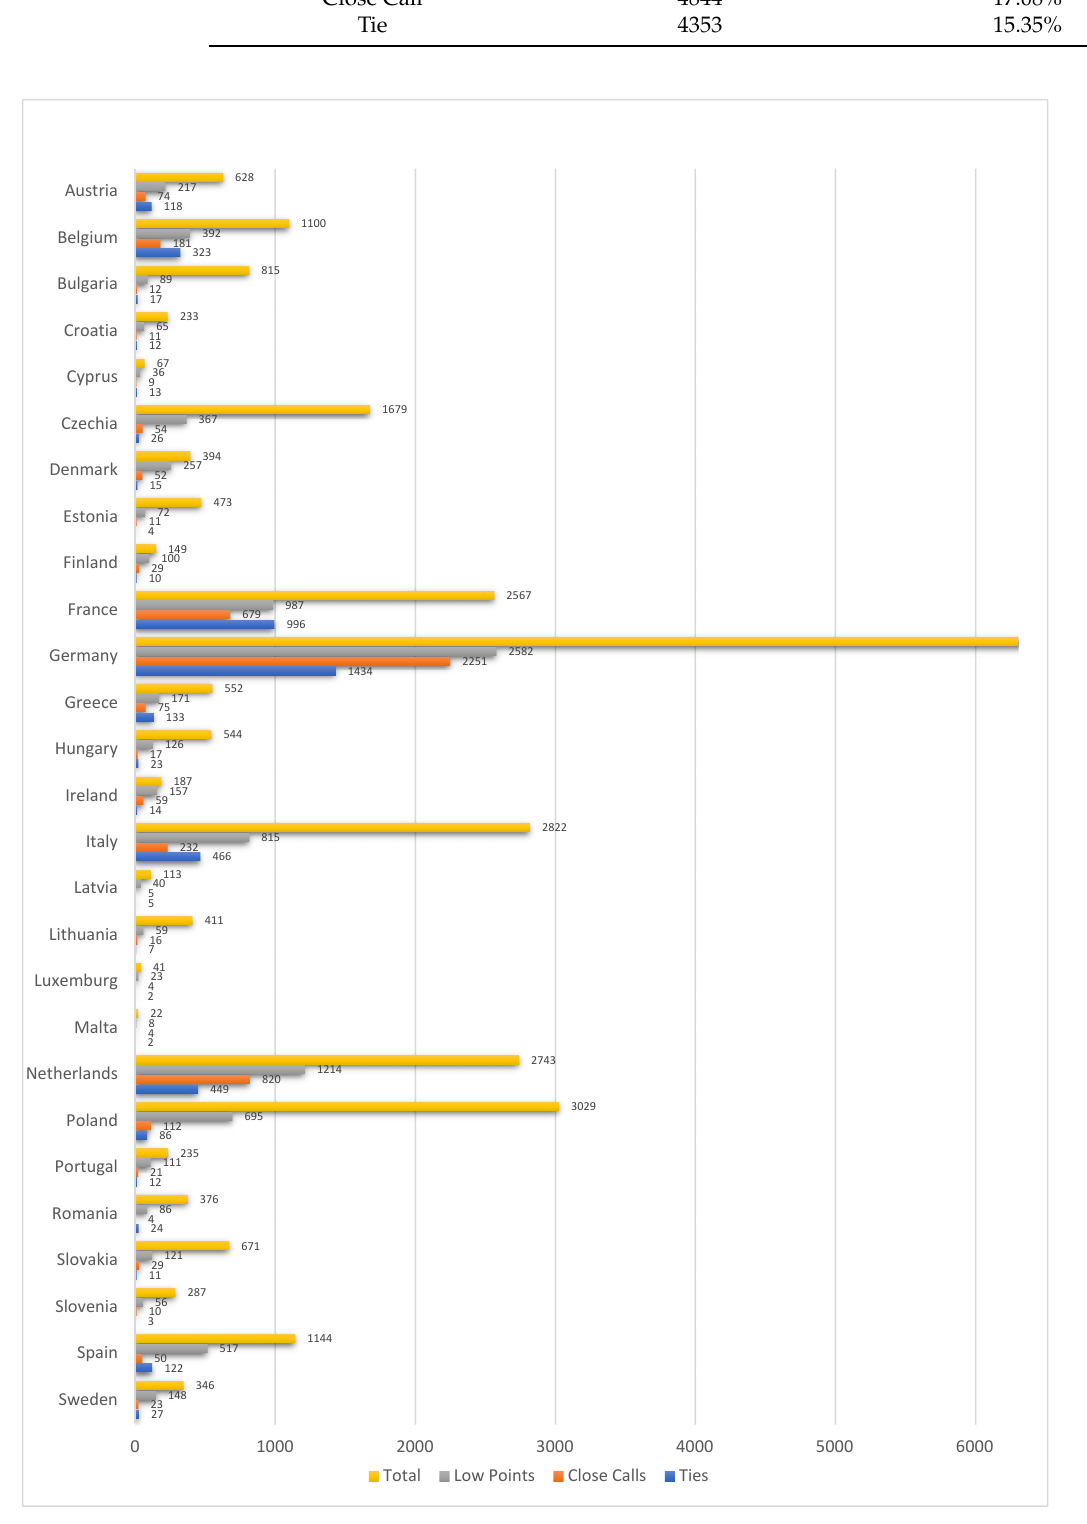
Figure 6. Domains with the .eu ccTLD by country out of a sample of 29,091